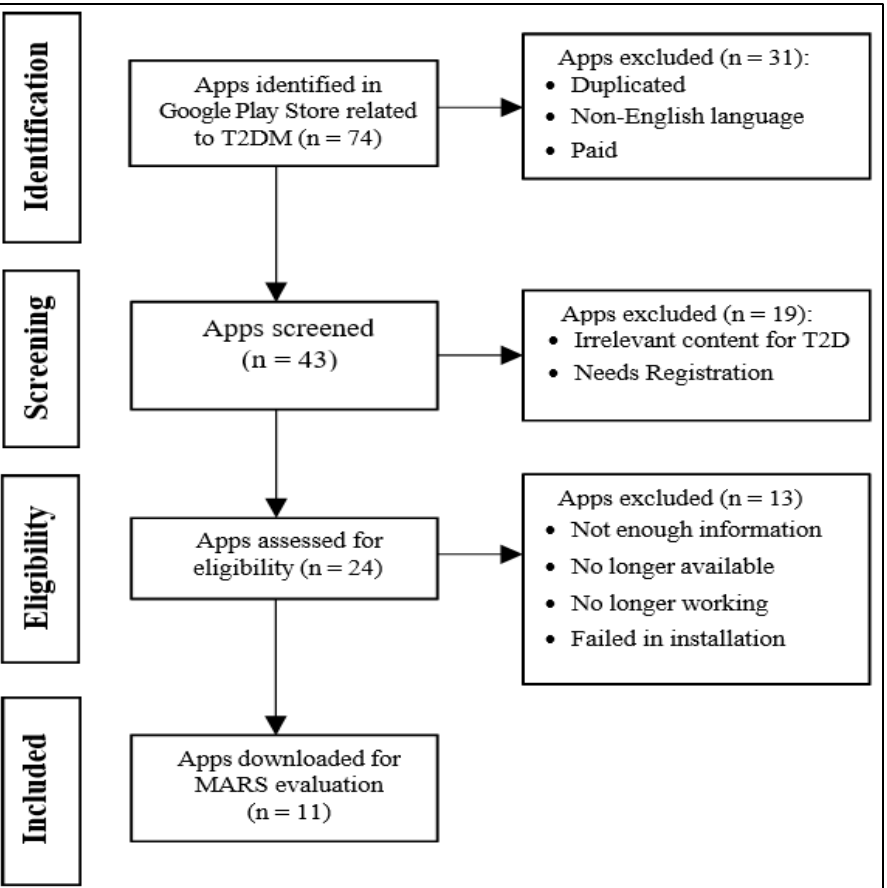
Figure 3. Systematic